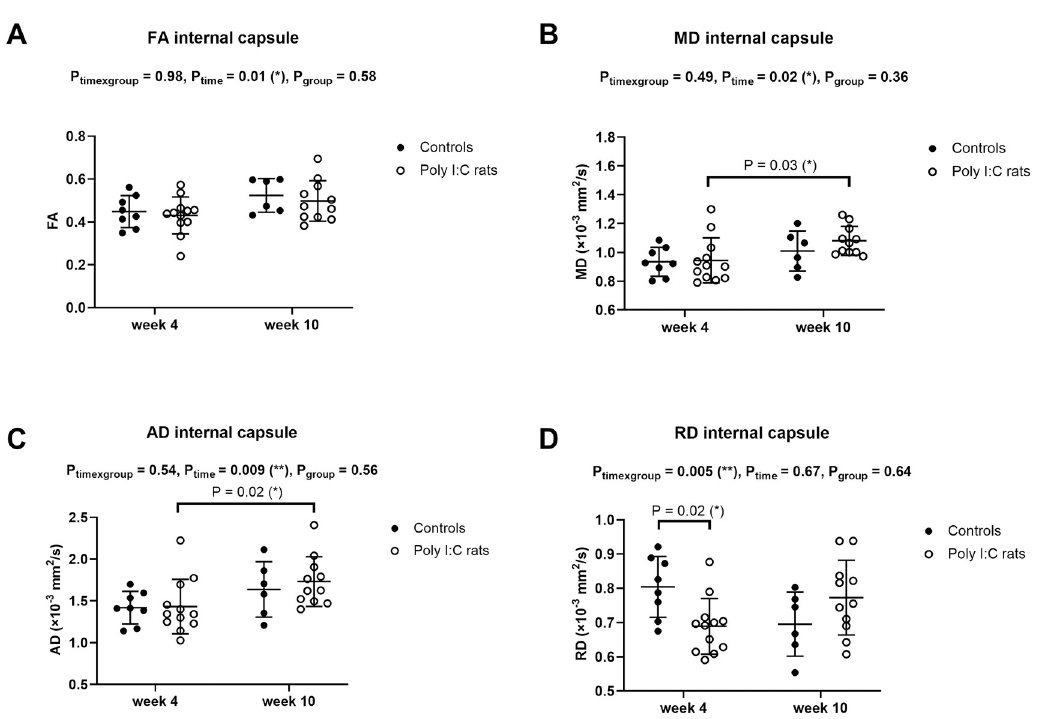
Fig 5. Internal capsule MR diffusion properties (mean ± standard deviation) in controls (•) and poly (I:C) rats ( � ) measured at 4 and 10 weeks after birth. (A) Fractional anisotropy—FA, (B) Mean diffusivity–MD, (C) Axial diffusivity–AD, and (D) Radial diffusivity—RD. MD and AD increased with age only in poly (I:C) rats. RD was lower in poly (I:C) rats at week 4. Data were analyzed with a mixed-effects model with Sidak’s multiple comparisons.